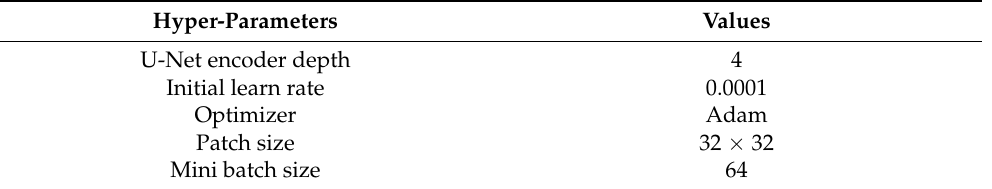
Table 1. Hyper-parameters used by CNN model.